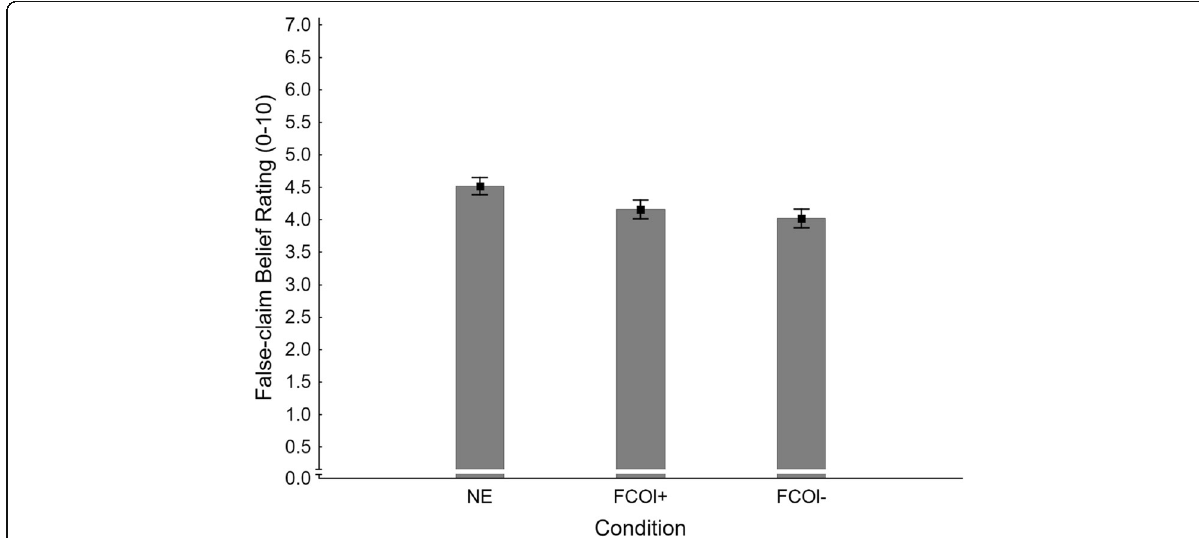
Fig. 13 Mean false-claim belief ratings across conditions NE (no-exposure) and FCOl± (fact-check-only, with/without cognitive load) in Experiment 3. Error bars show standard errors of the